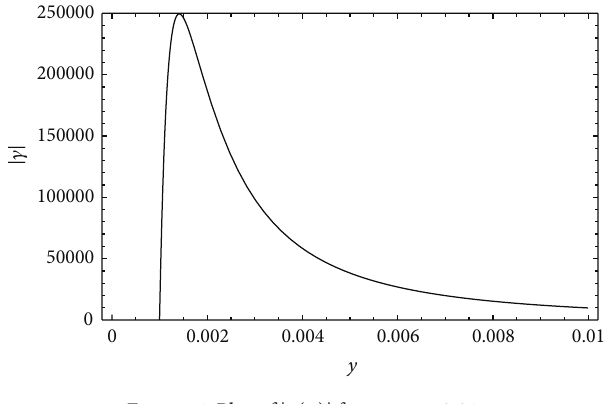
Figure 1: Plot of |𝛾(𝑦)| for 𝜖 ≤ 𝑦 ≤ 0.01 .